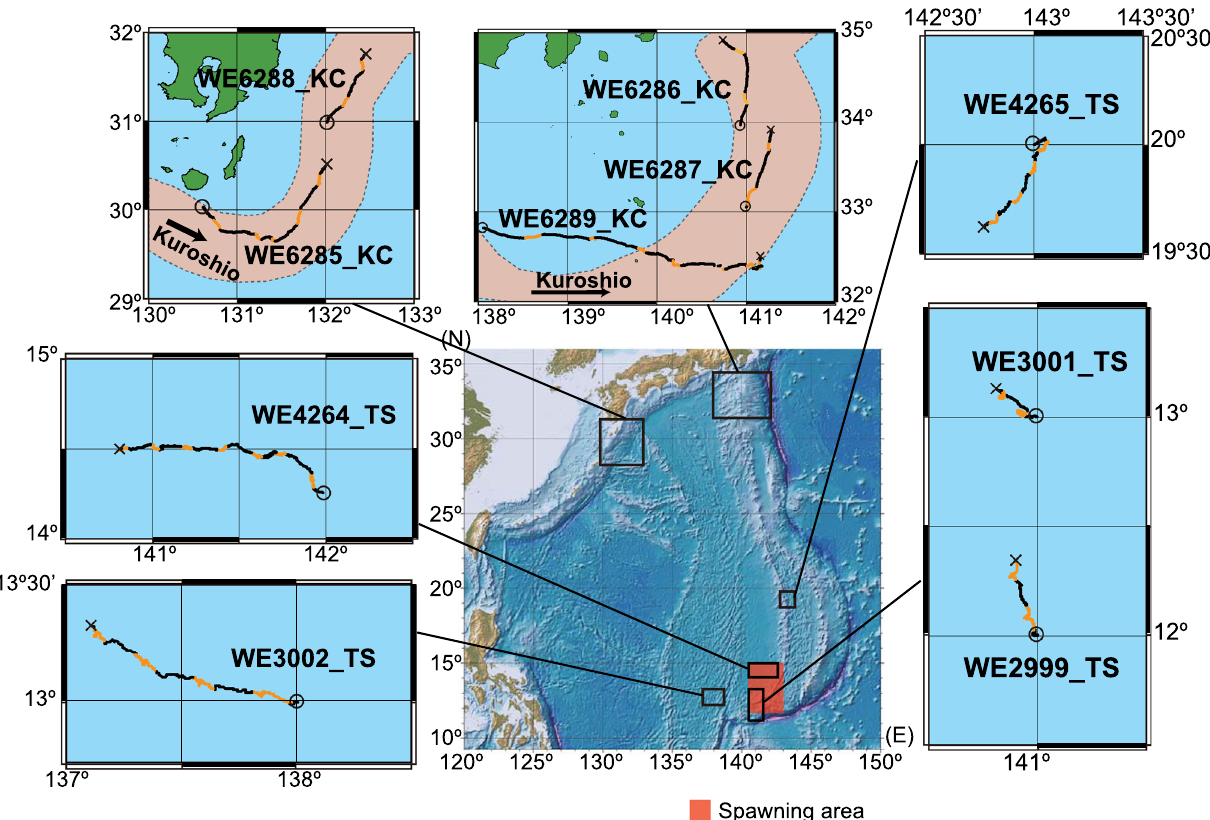
Figure 1. Track maps for ten eels used for analyses in this study. Trajectories of ship tracking ten eels during daytime (yellow line) and nighttime (black line). Start ( ○ ) and end points (×) of tracking. The topographic and bathymetric map (central bottom) were created using Generic Mapping Tools ver.4 (https:// www. gener ic- mappi ng- tools. org) and the database ETOPO1 grid (https:// www. ngdc. noaa. gov) was used. Other maps were drawn using QGIS software (https:// qgis. org) and the database GSHHG ver. 2.2.2 (http:// www. soest. hawaii. edu). These maps were further modified using Adobe illustrator ver. 24. The Kuroshio Current (orange area) is drawn based on the data from the Quick Bulletin of Ocean Conditions by the Japan Coast Guard’s Hydrographic and Oceanographic Department, collected on 28 November and 16 December 2012 (http://www1.kaiho.mlit.go.jp). The spawning area is predicted by collecting fertilized eggs, newly hatched larvae and matured adults is shaded in